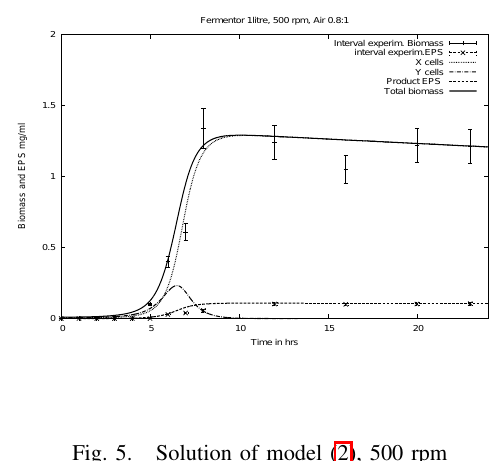
data has been done with an optimization